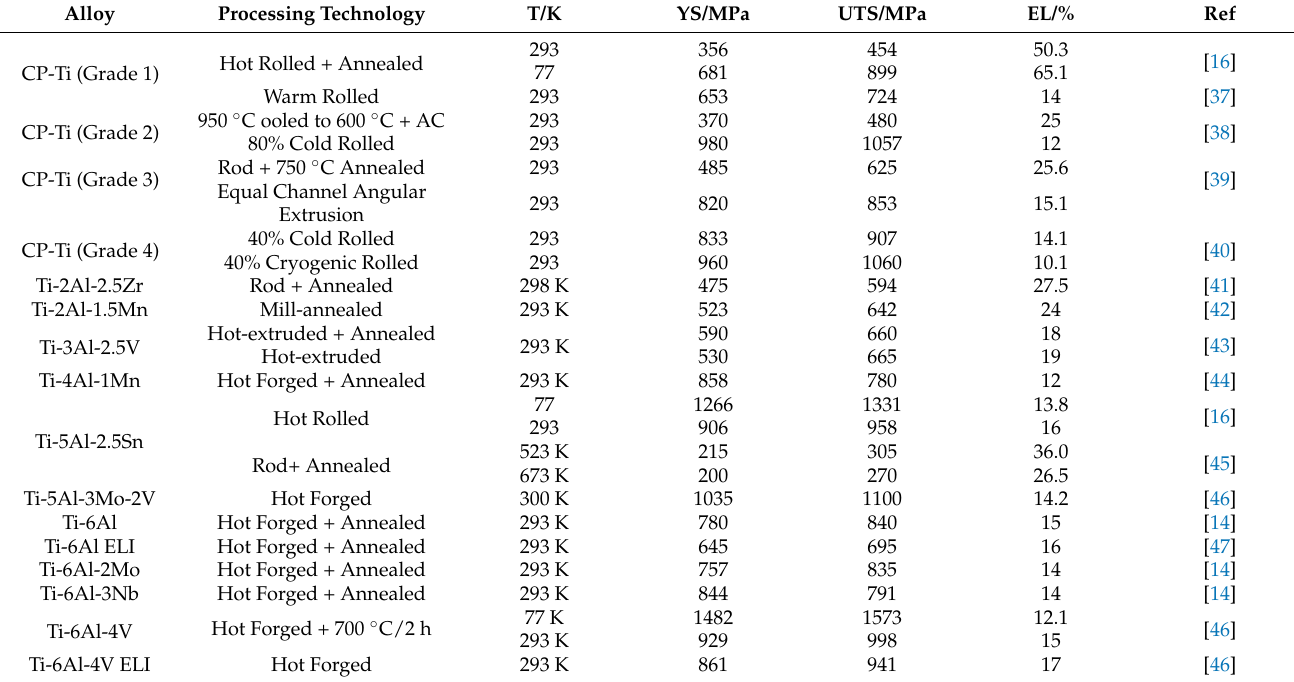
Table 1. Mechanical properties of typical α , near α and α + β